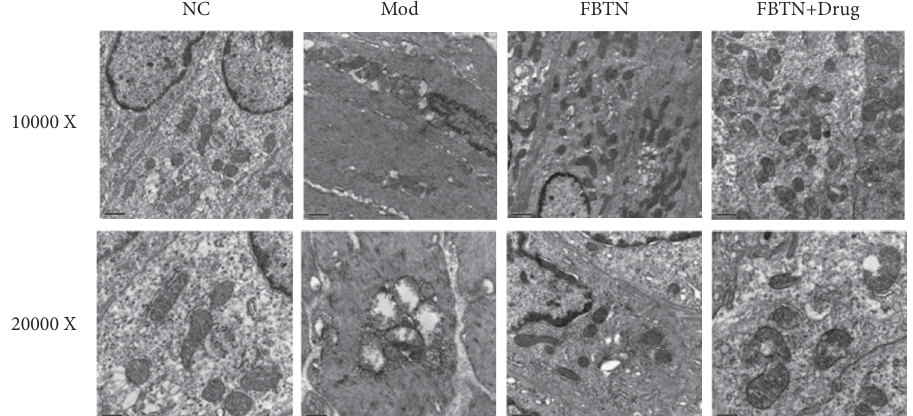
Figure 2: Abdominal massage protected the integrity of mitochondria in cells of the colonic mucosa. (a) Evaluation of cellular micro- structures in the colonic mucosa by transmission electron microscopy (TEM, upper panel: 10000 x , scale bar 0.50 μ m, down panel: 20000 x , scale bar 0.25 μ